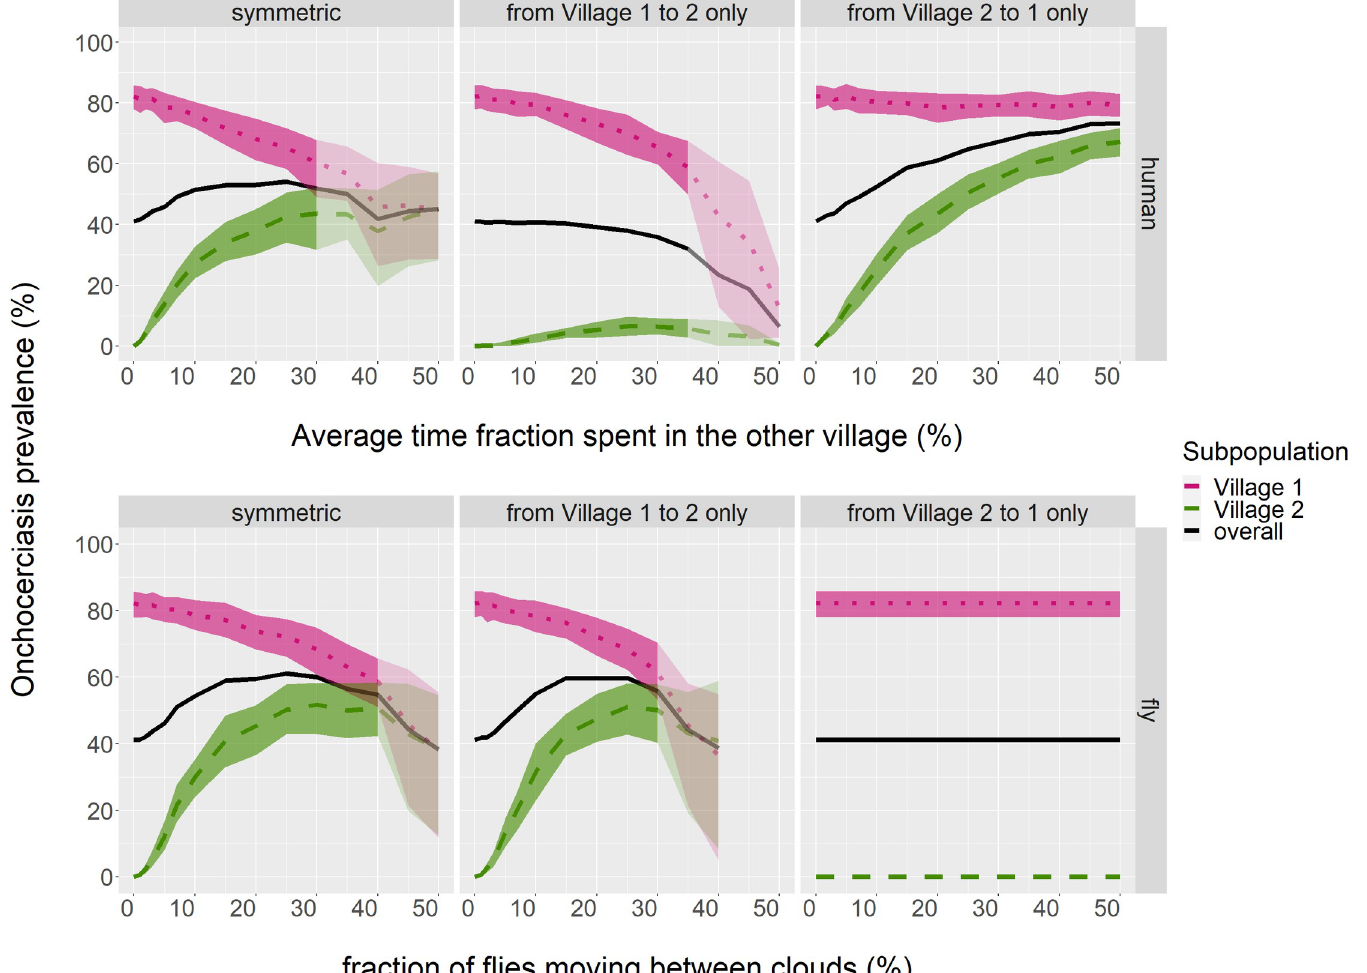
Fig 3. Spill-over equilibrium prevalence as influenced by the type of connection between two villages. ABR Village 1 = 16,000; ABR Village 2 = 4,000. Movement is either symmetric, i.e., the same number of inhabitants or flies travel to Village 1 from Village 2 as vice versa (left panels), or travel occurs only by those from one of the two villages (middle and right panels). The average time fraction in the other village, or the fraction of flies moving between clouds parameter, is set only for those that do travel, i.e. symmetric movement here represents the addition of the other two types of travel. Bands represent the 80% inter-decile range over the aggregate of monthly data-points for all runs. Transparency shows where 1–20 of the 40 runs ended with onchocerciasis eliminated; mean and variance were then calculated over remaining runs only, and lines are cut off where > 20 runs had onchocerciasis disappear. Prevalence is among those aged 5+ years.